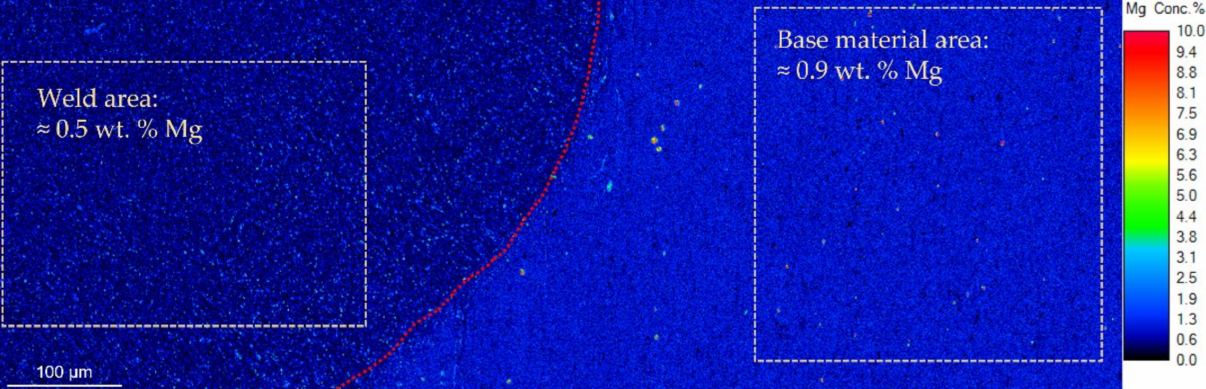
Figure 7. Detection of magnesium in the weld ( left ) via the fusion line (red dotted line) into the base material ( right